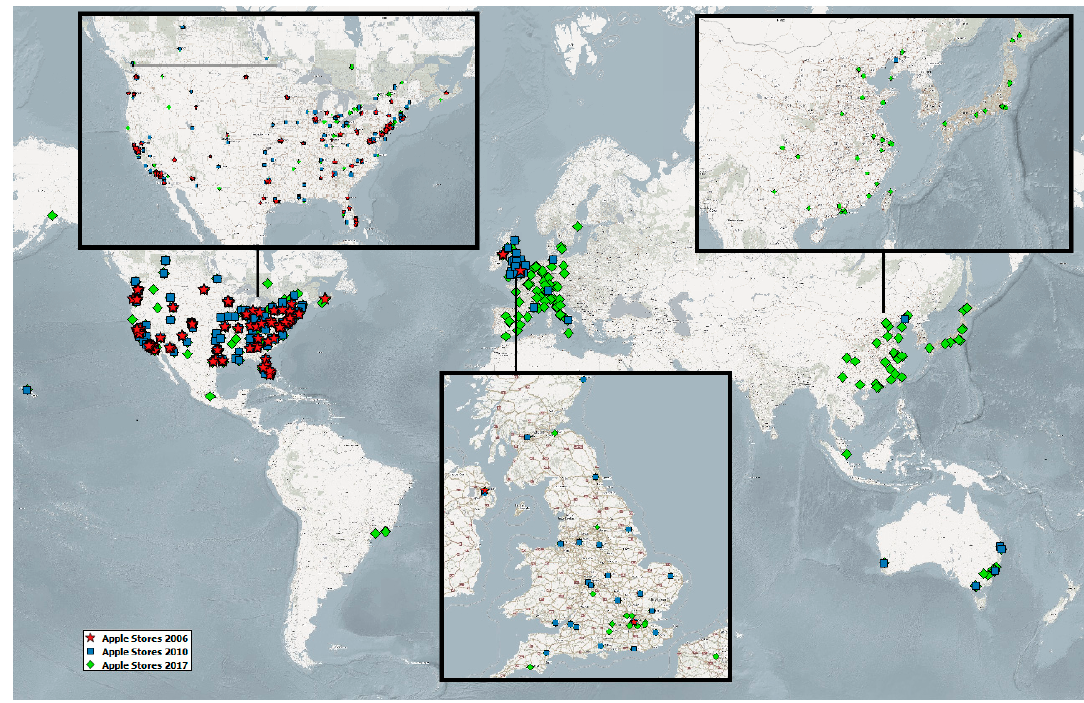
Figure 13. Global Apple Store openings 2006–2017 (World Mercator Projection).